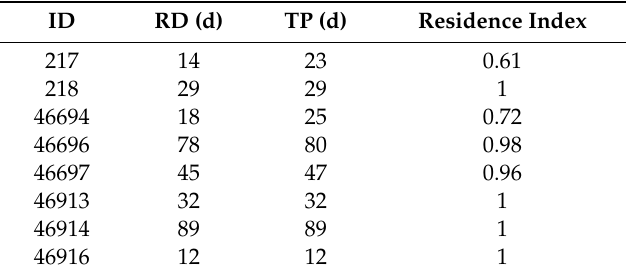
Table 2. Residence days (RD), the total period (TP) being detected and the residence index of the tagged common carp individuals in the Zhaoqing section of the West